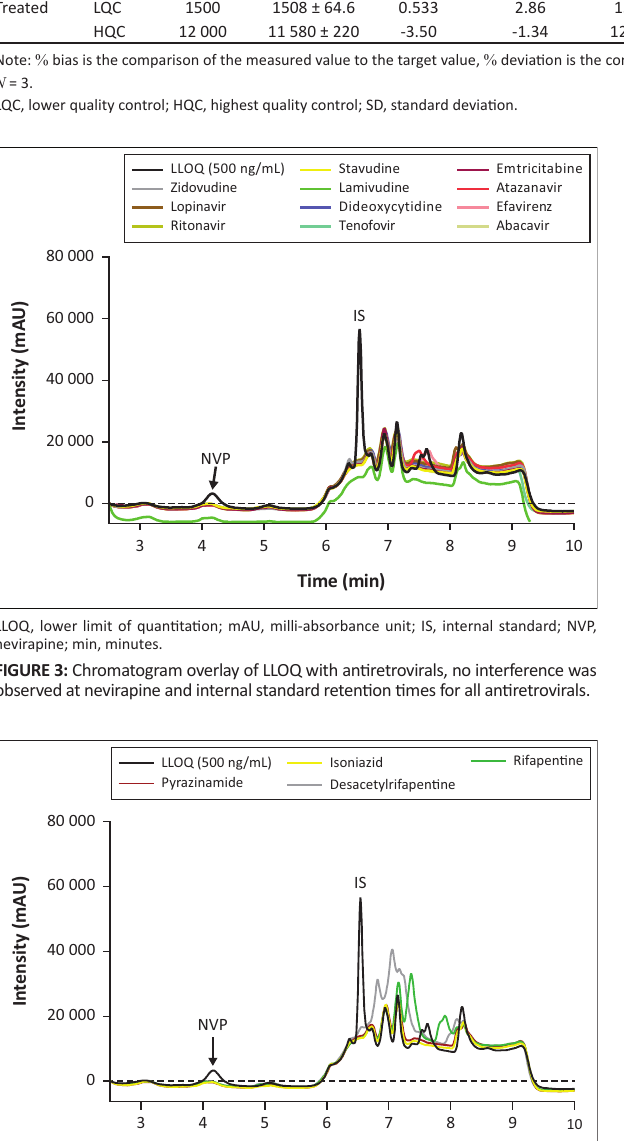
TABLE 2: Nevirapine stability over different conditions at University of Zimbabwe International Pharmacology laboratory. Variable QC Controls